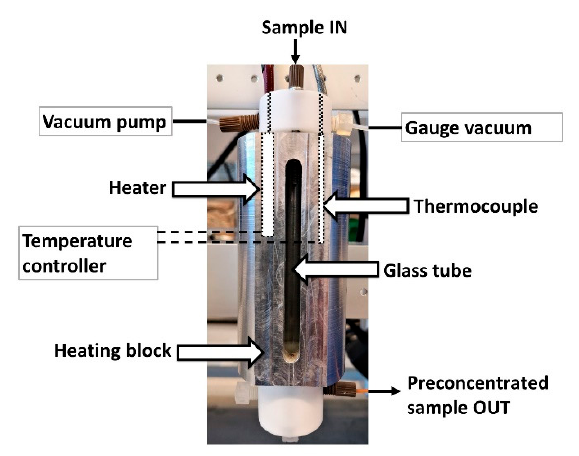
Figure A1. Evaporation